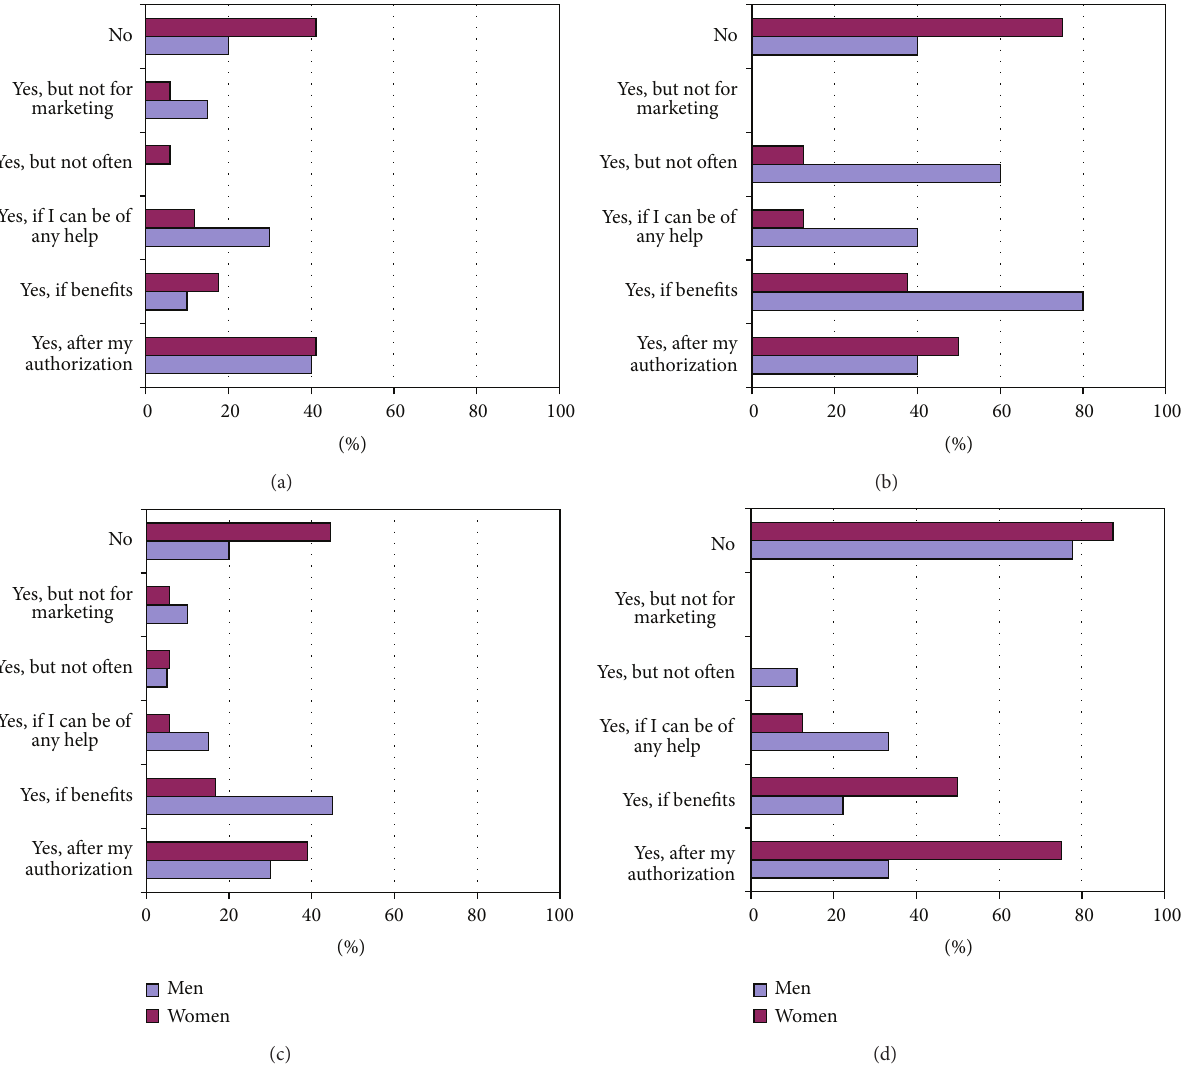
Figure 18: Will to be contacted according to the tweet or photo location: (a) DN who claim to use location-aware applications; (b) DN who claim not to use location-aware applications; (c) DI who claim to use location-aware applications; (d) DI who claim not to use location-aware